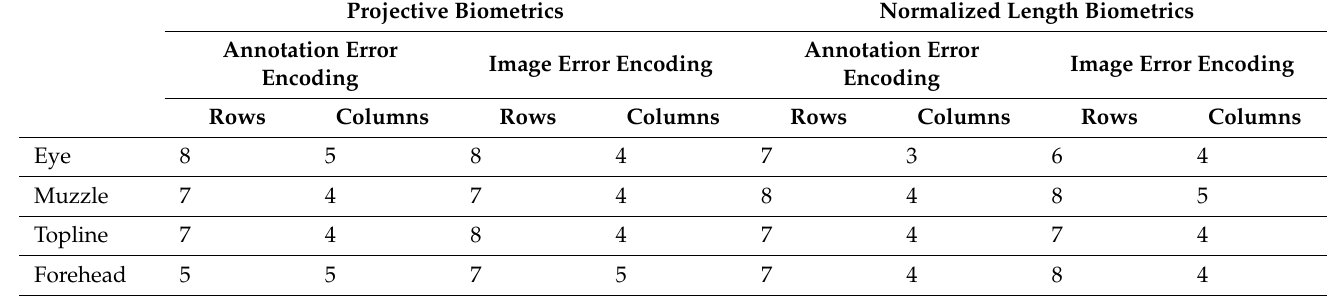
Table 1. Summary of encodings granularities recovered using data mechanics clustering for projective biometrics and normalized length biometrics for both the annotation and image error bias correction factors. Complete results of data mechanics analyses are provided in Supplemental